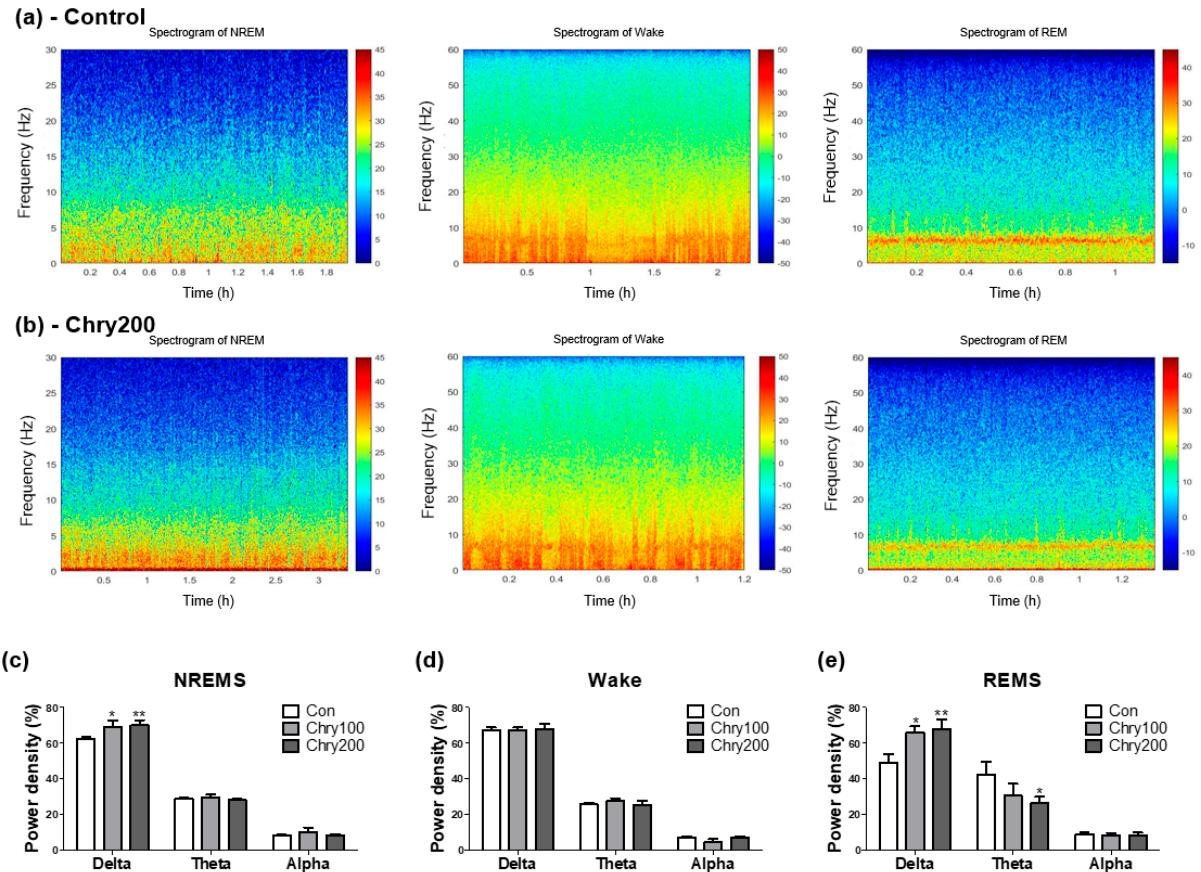
Figure 4. Time-dependent power spectrum heatmaps. After the administration of Chry ext (100 and 200 mg/kg) once a day for 7 days, EEG/EMG recorded for 6 h (10:00–16:00) at the last administration were used. The representative power spectrum heatmaps, drawn with time on the X -axis and frequency on the y -axis, show the representative figures showing the characteristics of each group’s REMS, Wake, and NREMS states ( a , b ). Jet colormap was used for the data range displayed on the right side of the heatmap, and the range of expression was adjusted so that the characteristics of each state were clearly displayed. % of EEG power spectrum densities during NREMS ( c ), Wake ( d ), and REMS ( e ). Data are expressed as mean ± SEM. * p < 0.05, and ** p < 0.01, compared with the control group. Chry, Chrysanthemum morifolium extract; REMS, rapid eye movement sleep;